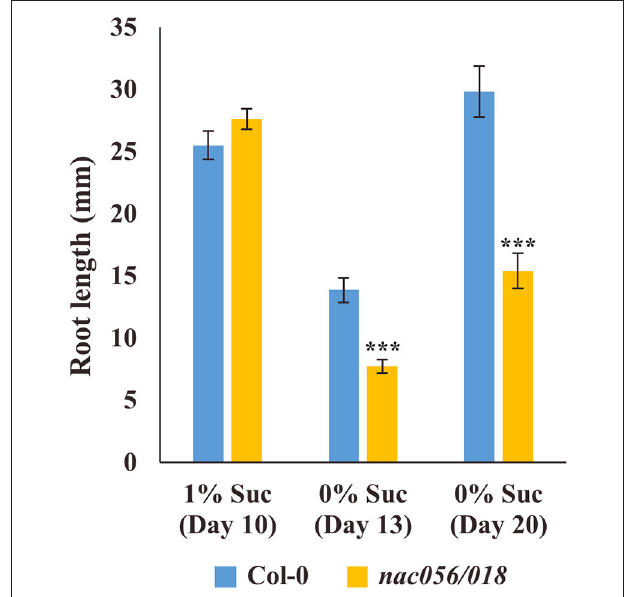
FIGURE 10 | Root growth assay of nac056/018 mutant in presence or absence of added sucrose. Seeds of Col-0 or nac056/018 were grown on nutrient agar plates in the presence or absence of 1% (w/v) sucrose. After 10 days in the presence of sucrose, root growth in the two lines was comparable. At 13 days in the absence of sucrose, root growth of nac056/018 was significantly reduced compared to Col-0, and this reduction continued for roots grown for 20 days in the absence of sucrose. Data shows mean ± SE for root length, student’s t -test, *** P < 0.001, n ≥ 15.